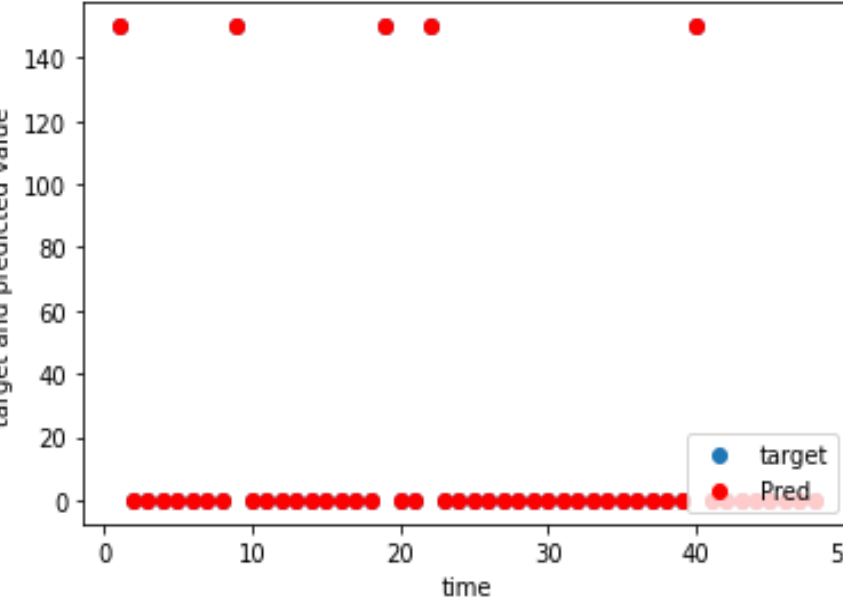
Figure 18. Charging demand prediction of a weekend for Leppävaaran asema.